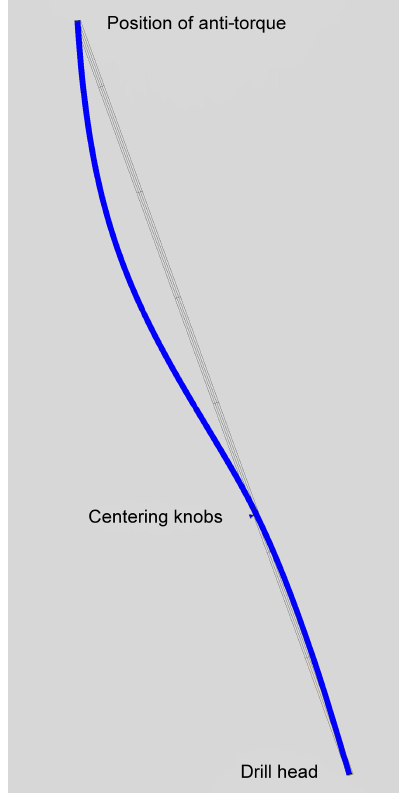
Figure 12. Bending of drill by gravity (exaggerated). Finite-element simulation with actual material properties and tests with the drill itself led to an optimal position of the centering knobs at about one- third from the lower